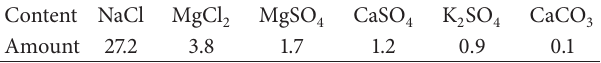
Table 3: Content of seawater (g/L).